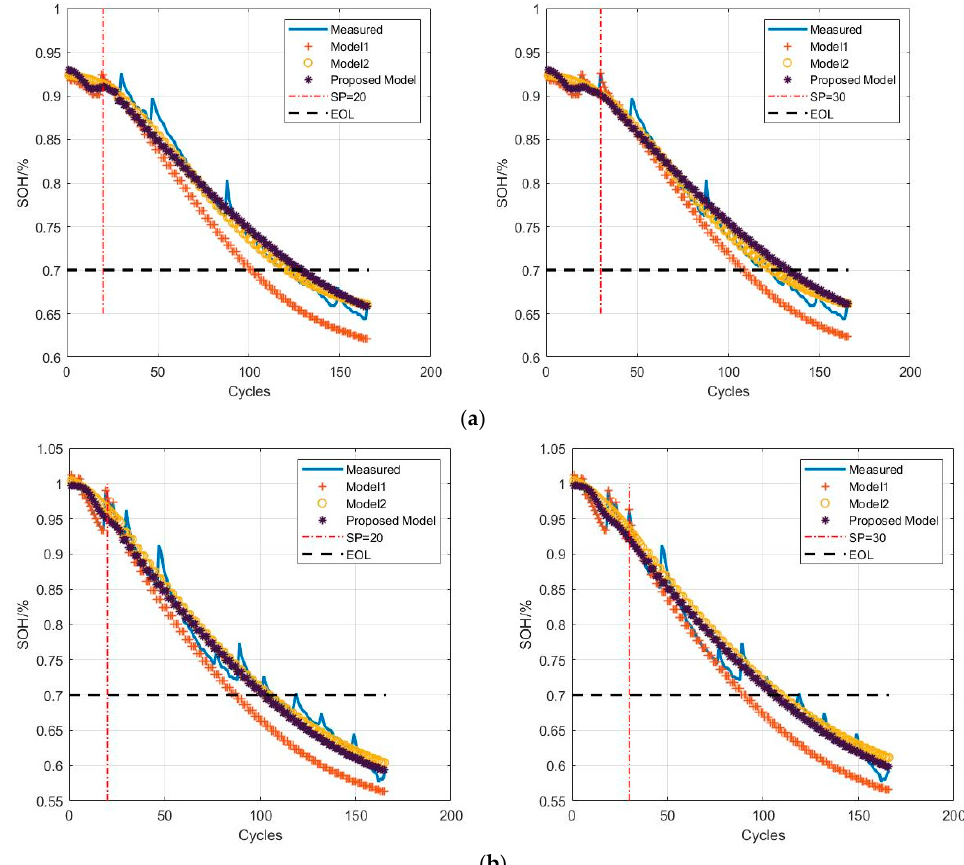
( b ) Figure 10. Performance of different sequence length: ( a ) CACLE dataset; ( b ) NASA dataset. In the NASA data, B5 and B6 are used for testing, while B7 and B18 are used for training. The EOL of each battery is set at the moment that battery declines to 70% of the nominal capacity in the NASA dataset. Figure 11 shows the RUL prediction results of B5 and B6 in the NASA dataset, of which the RUL prediction RE of B5 is 5.6% and 4.0% when starting from 100 and 200, respectively. The prediction error of B6 is 8.2% and 4.5% when the prediction starts from 100 and 200, respectively. For NASA, we can see from the figure that the effect of prediction and regression of the data after emd and vmd is similar, be- cause the noise of the original data itself is not very much. In this way, a simpler emd can achieve good results, and even the emd effect of a battery is better than that of vmd. Such as the prediction of 20% of B5. Figure 10a shows the comparison of prediction results un- der different sequence lengths. It can be seen from the chart that when the optimal sliding window is selected, NASA’s optimal sequence to sequence is 7 to 3. For B5, when the sequence length is 9 to 1, 8 to 2, 6 to 4, and 5 to 5, it is 0.0122, 0.0120, 0.0126, and 0.0127, respectively. For B6, when the sequence length is 9 to 1, 8 to 2, 6 to 4, and 5 to 5, it is 0.0138,